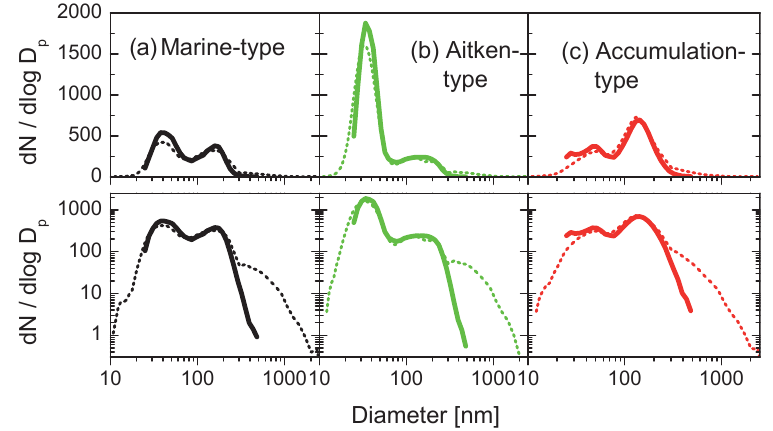
Figure 1. Exemplary NSDs measured during three different ACTOS flights in the SCL between 100 and 400m on ACTOS (thin dotted lines) and on the ground (thick solid lines), shown with a linear (top) and a logarithmic (bottom) scaling on the y axis. Ground-based measurements from 25 to 500nm were done using a DMPS, while size distribution measurements on ACTOS were composed from measurements of an SMPS, measuring from 6 up to 230nm, and an OPC covering the size range of 250 to 2500nm. All data shown here and on any other plot in this study are given for STP.